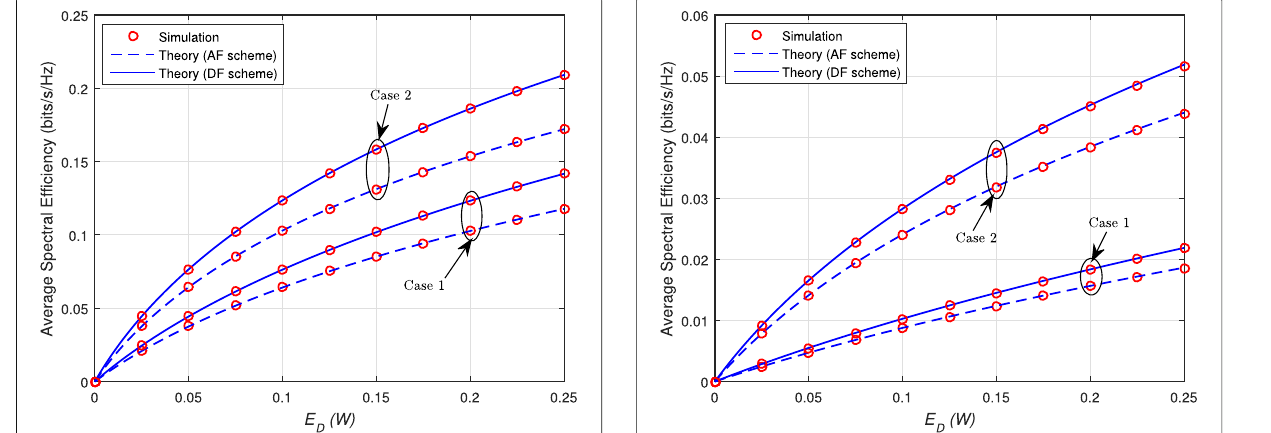
of the hybrid HTPS relaying protocol achieves its optimal values when the TS and PS fraction pair ranges from 0 to 0.7, 0 to 0.4, respectively, with parameters, i.e., E D = 10 dB and κ = 0.15.